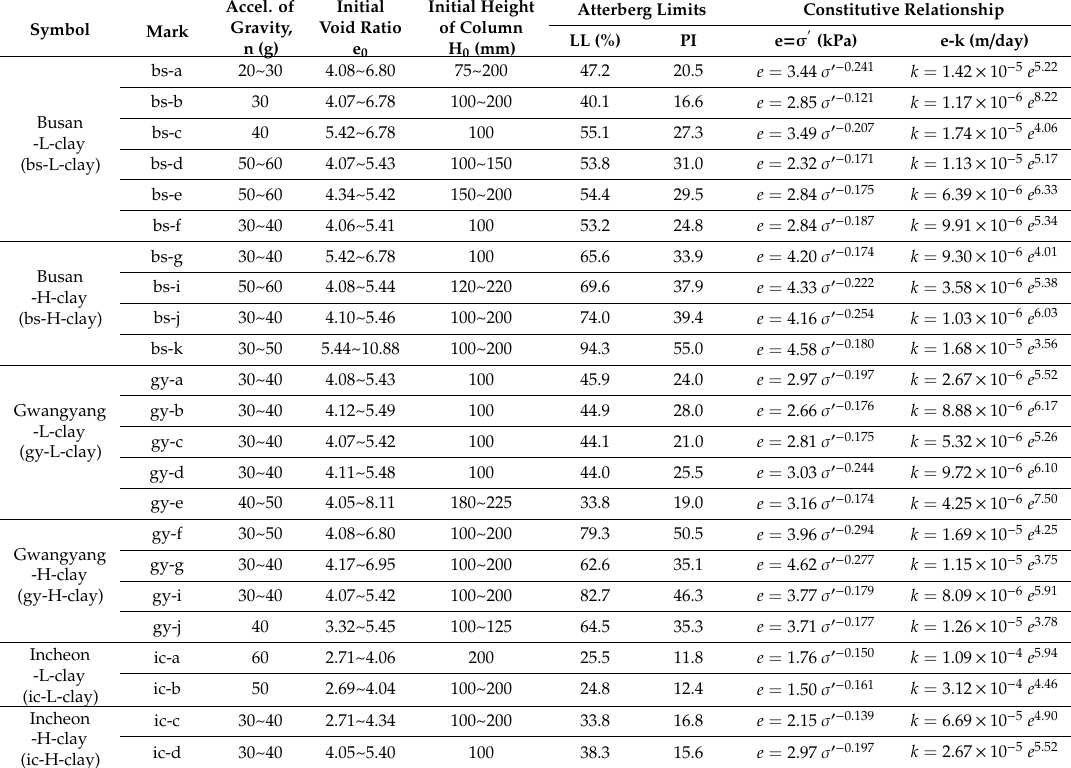
Table 2. Centrifugal experimental conditions and results.